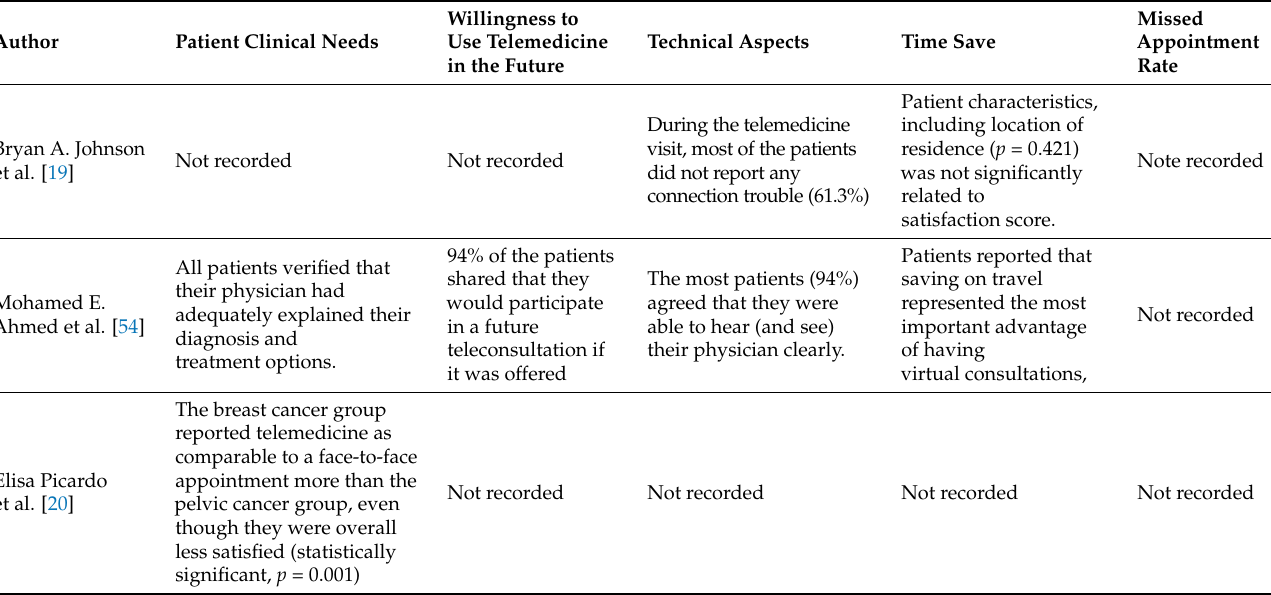
Table 2. Summary of the studies on other aspects of